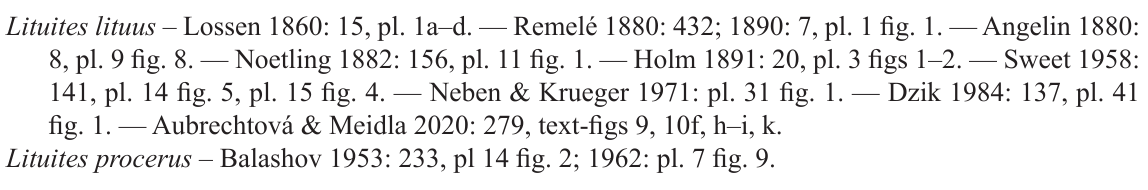
fig. 1. — Aubrechtová & Meidla 2020: 279, text-figs 9, 10f, h–i, k. Lituites procerus – Balashov 1953: 233, pl 14 fig. 2; 1962: pl. 7 fig.